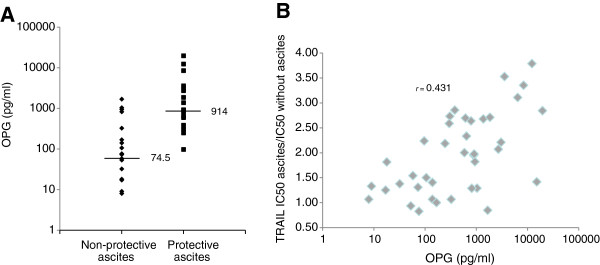
Concentration of OPG in ascites according to their anti-apoptotic effect against TRAIL. (A) OPG ascites levels in 40 patients with OC in non-protective versus protective ascites against TRAIL as defined in Methods. Horizontal bars represent median values. (B) Correlation chart of OPG levels in ascites versus the anti-apoptotic activity of ascites. The correlation coefficient (r) is indicated.